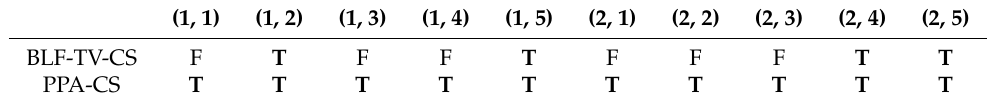
Table 1. Comparison of different image segmentation methods as to whether the estimated shape of the foreground region of each image shown in Figure 2a was convex from vision, where the notation ( i , j ) corresponds to the image shown in Figure 2a ( i , j ) ( i = 1 : 5, j = 1 : 2 ) and the notation “T” means the corresponding estimated shape was convex. Otherwise, the notation “F” was given.